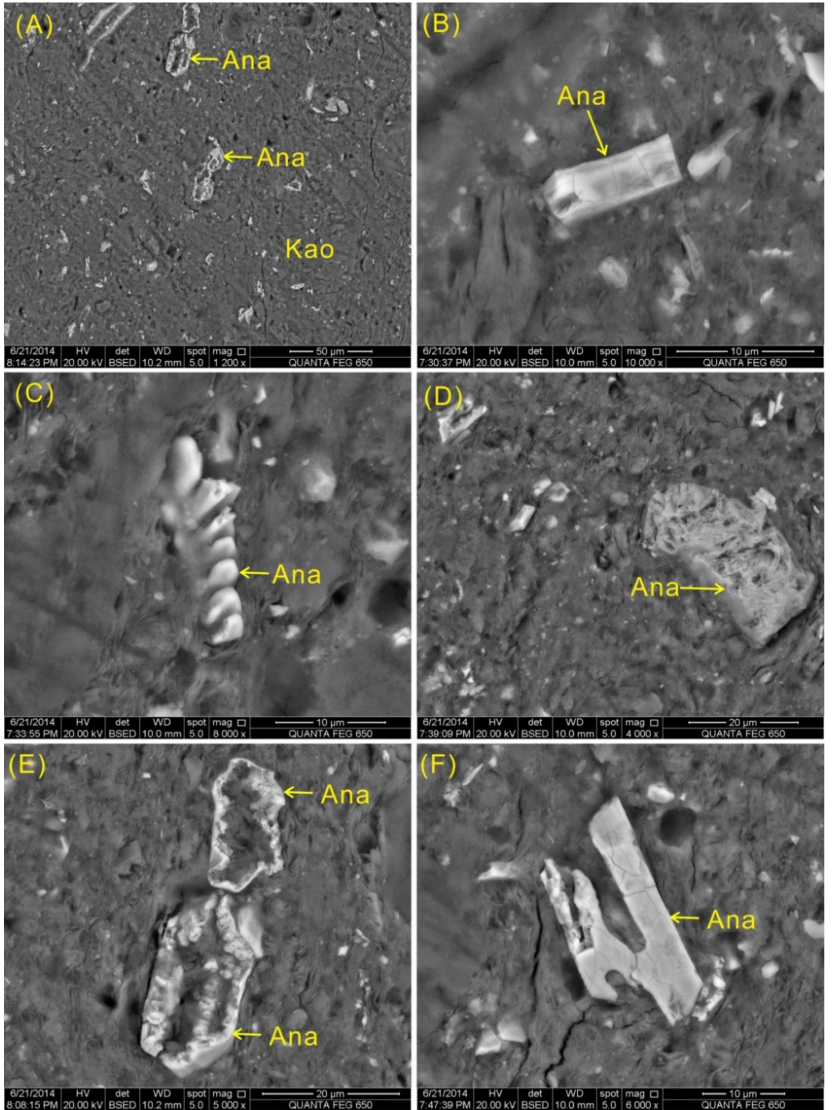
Figure 16. SEM back-scattered electron images of minerals in C1-2f. ( A ) Microcrystalline kaolinite matrix and anatase crystals. ( B ) Euhedral anatase crystal. ( C – E ) Altered anatase framework. ( F ) Anatase with high temperature cracks and embayments. Ana: anatase. Kao: